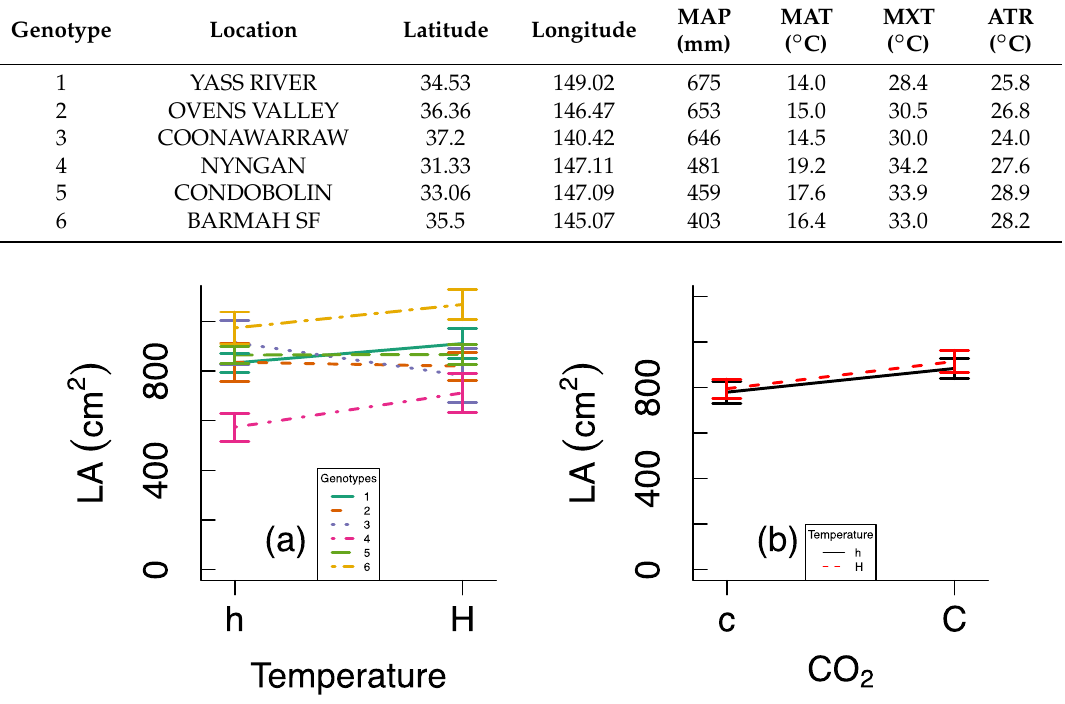
Figure A1. Variation in leaf area (LA) across genotypes, heat waves, and CO 2 concentrations. Data are presented as reaction norms for six genotypes as a function of temperature ( a ) and as reaction norms for temperature as a function of CO 2 treatment ( b ). Error bars indicate standard errors.